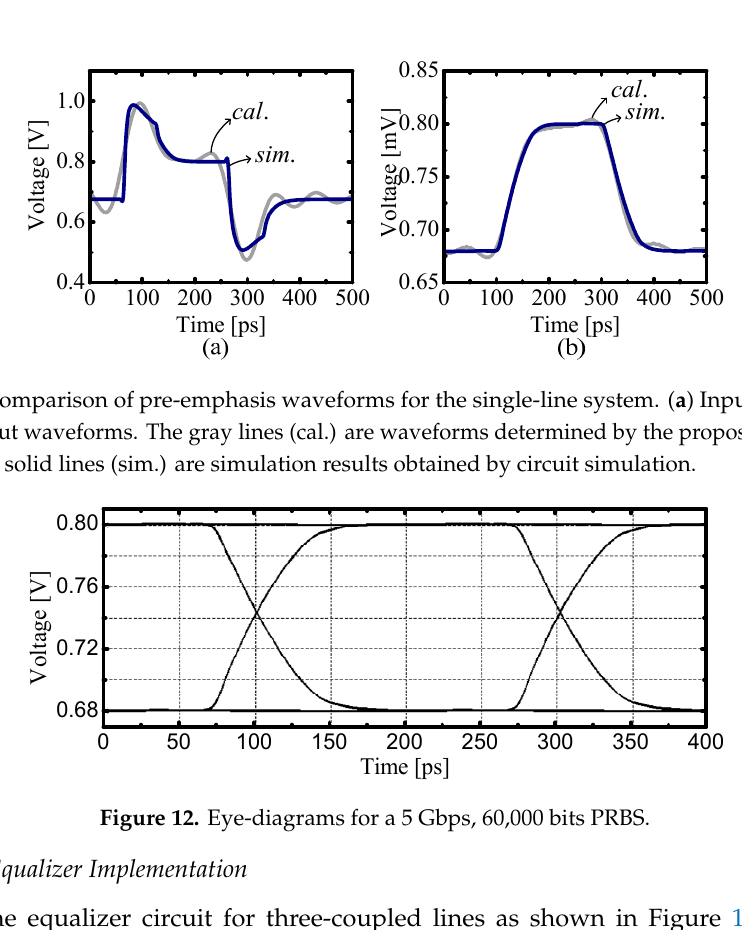
Figure 10. Description of the TX for the single-line system. The line is implemented by segment model with resistors, capacitors, and inductors. The detailed circuit parameters are and